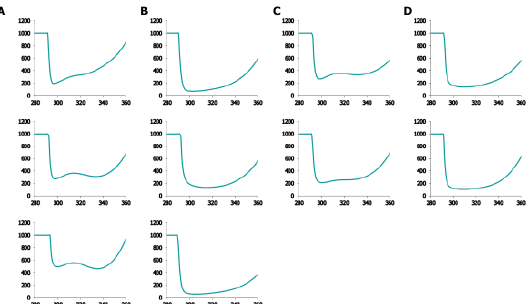
FIGURE 1: Fluorescence Spectra of A) Fmoc-S-PEG B) S-PEG C) Fmoc- DS-PEG D) DS-PEG E) Fmoc-GDS-PEG F) GDS-PEG G) Fmoc-RGDS- PEG H) RGDS-PEG I) Fmoc-GRGDS-PEG and J) GRGDS-PEG. X and Y axis represent Wavelength (nm) and Intensity respectively.